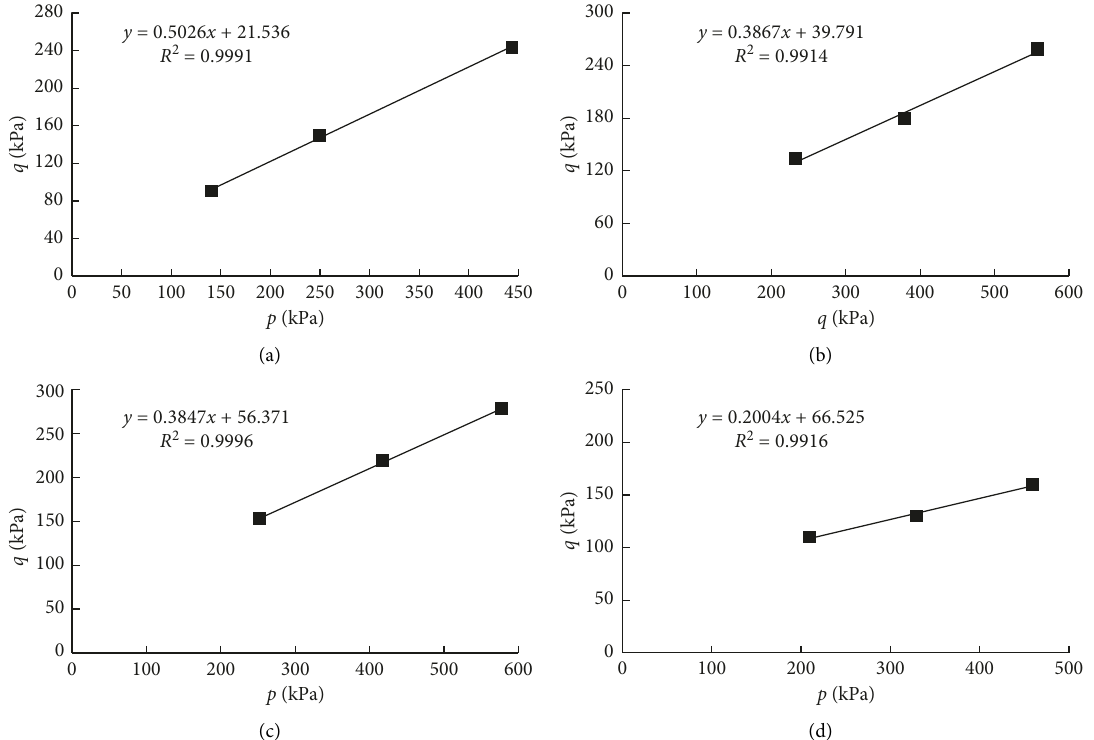
Figure 15: p-q curve of acid-contaminated clay cured by SAP with different mass percentage. (a) 3% HCL. (b) 5% SAP. (c) 10% SAP. (d) 15% SAP.